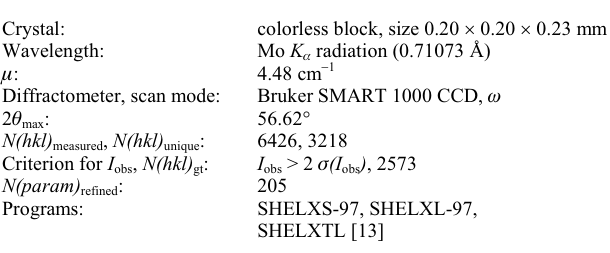
Table 1. Data collection and handling.